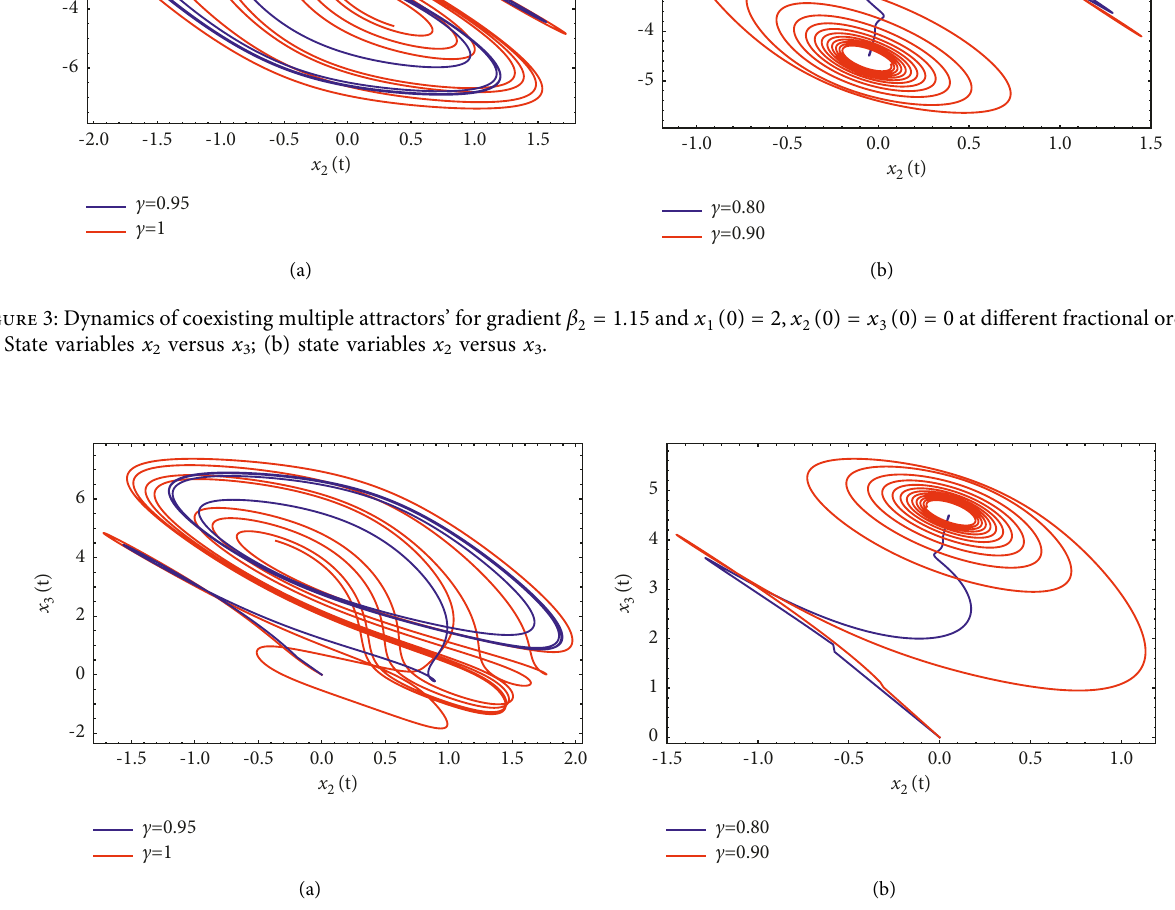
� 1 . 15 and x ( 0 ) � − 2 ,x ( 0 ) � x ( 0 ) � 0 at different fractional orders. 1 2 3 2